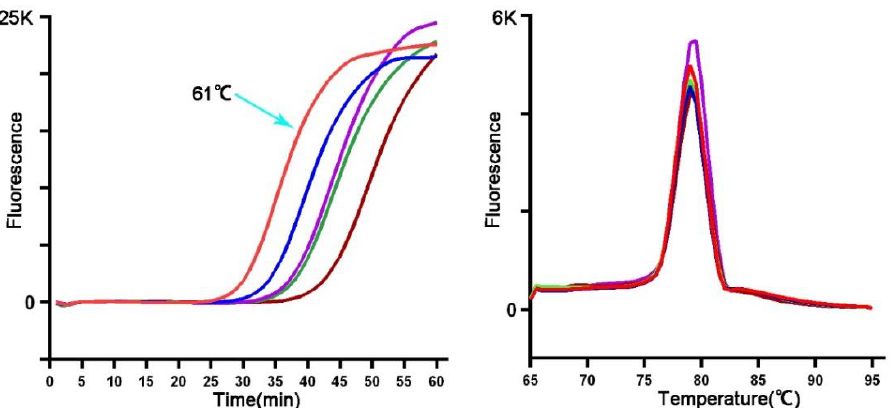
Figure 3. Different reaction temperatures (range: 59 to 63 °C) were tested to determine the optimal reaction temperature of LAMP. The optimal incubate condition was 61 °C for 60 min with an anneal derivative temperature of 79 °C.